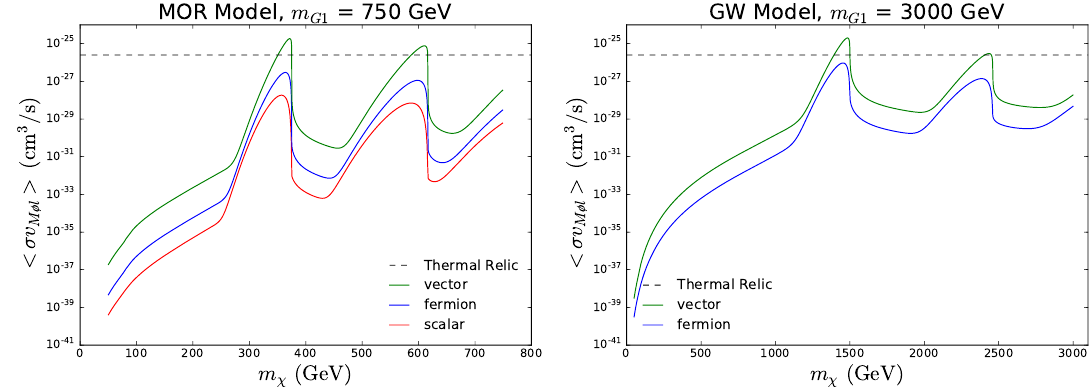
Figure 5 . The thermally averaged cross section times M(cid:28)ller velocity for the MOR (left) and GW (right) benchmark models. The value of h (cid:27)v i associated with the observed thermal relic abundance of DM value is shown by the black dashed